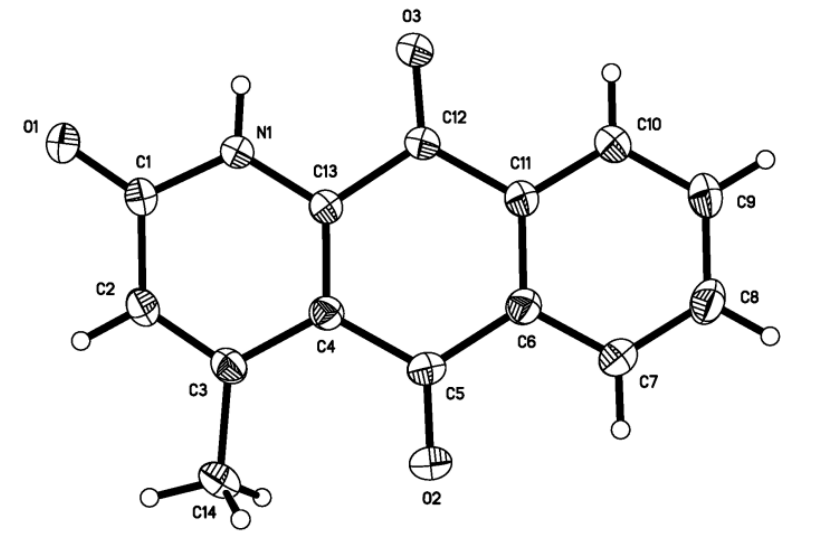
Figure 2. Molecular structure of the title compound.